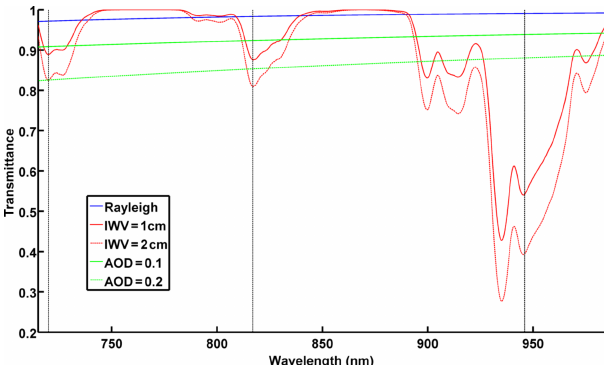
Figure 2. Transmittance of water vapour, aerosols and Rayleigh scattering in the spectral region 700–1000nm, calculated using MODTRAN set at 0.1nm resolution, at SZA = 0 ◦ IWV = 1cm, IWV = 2cm and AOD = 0.1 and AOD = 0.2 at 700nm using an Ångström exponent of 1.5. Black vertical dotted lines represent WMO recommendations for IWV